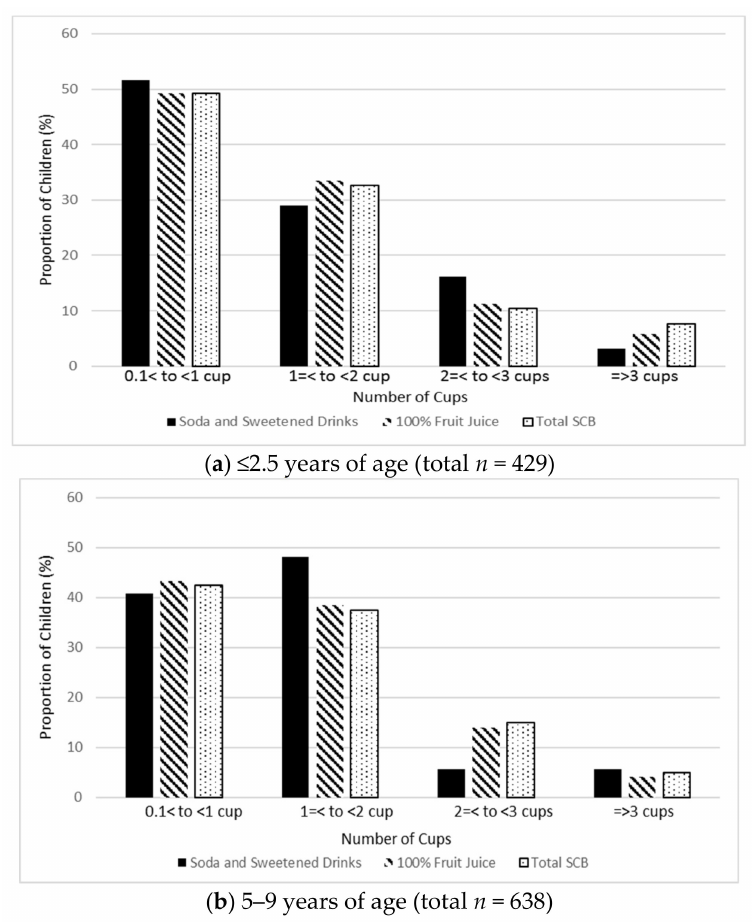
Figure 2. Distribution of sugar-containing beverage (SCB) intake among children in the TARGet Kids! Research Network among children who “ever consumed”